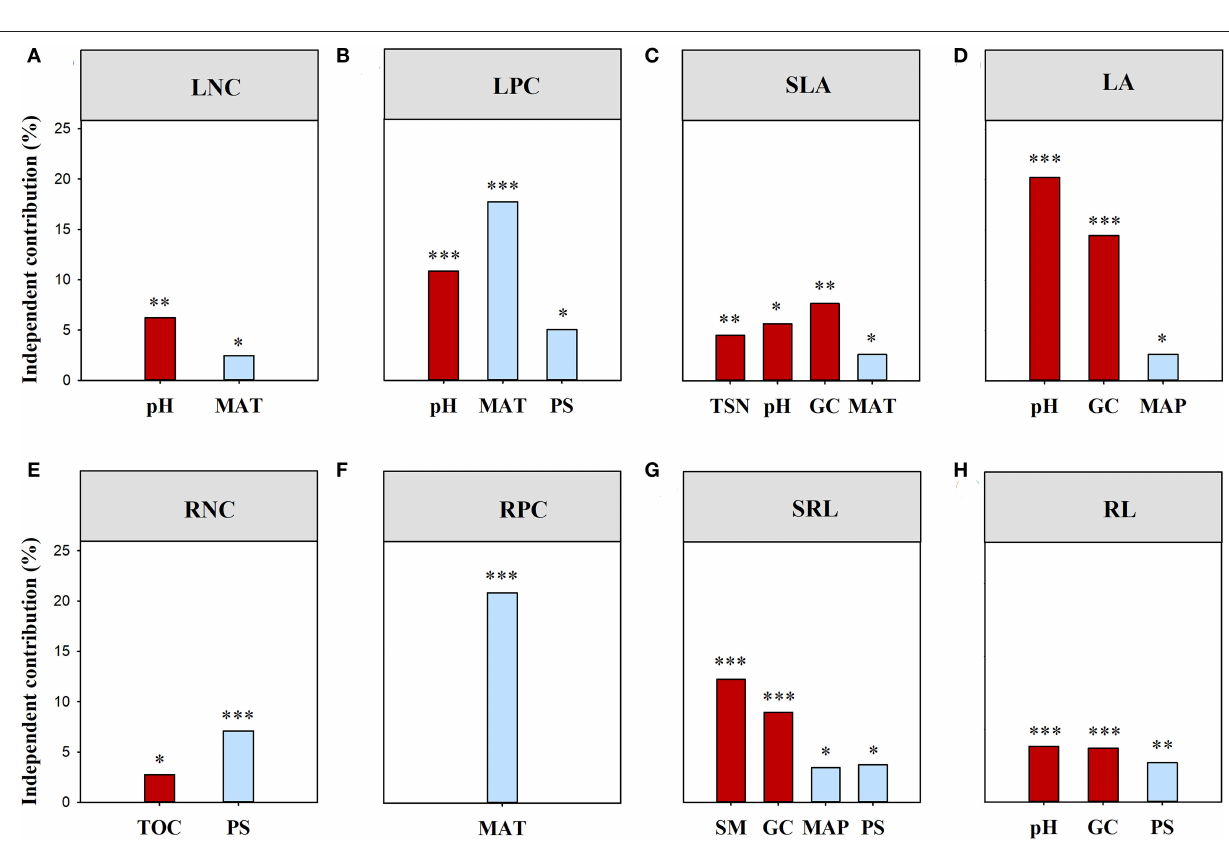
FIGURE 4 | Independent influence of major variables on the variations in the standard effect size of MPD for the individual trait. MPD, mean pairwise distances. TSN, soil total nitrogen content; TOC, soil organic carbon content; SM, soil moisture; PS, precipitation seasonality; MAP, mean annual precipitation; TS, temperature seasonality; MAT, mean annual temperature; All traits, all traits combined; LNC, leaf nitrogen concentration; LPC, leaf phosphorus concentration; SLA, specific leaf area; LA, leaf area; RNC, root nitrogen concentration; RPC, root phosphorus concentration; SRL, specific root length; RL, root length. ***, p < 0.001; **, p < 0.01; *, p <